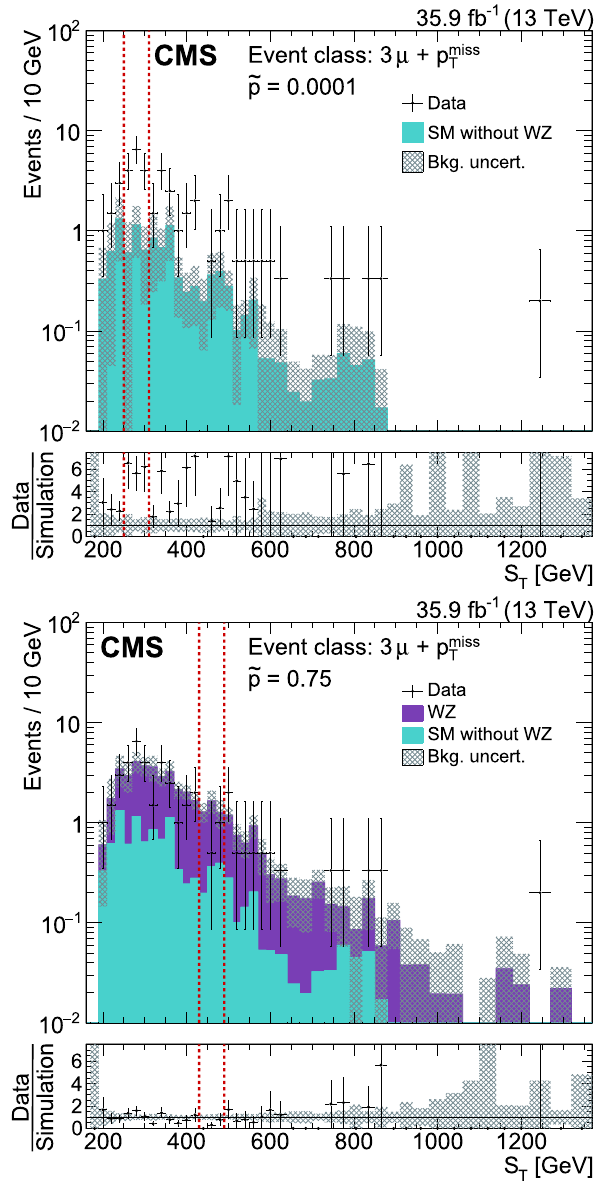
Fig. 7 Distributions of S T for the 3 μ + p miss exclusive class without T (upper) and with (lower) WZ production as part of the SM simulation. The data events are shown in black and the simulations of the SM processesareshownascolouredhistograms.Theregionenclosedwithin the red dashed lines is the region of